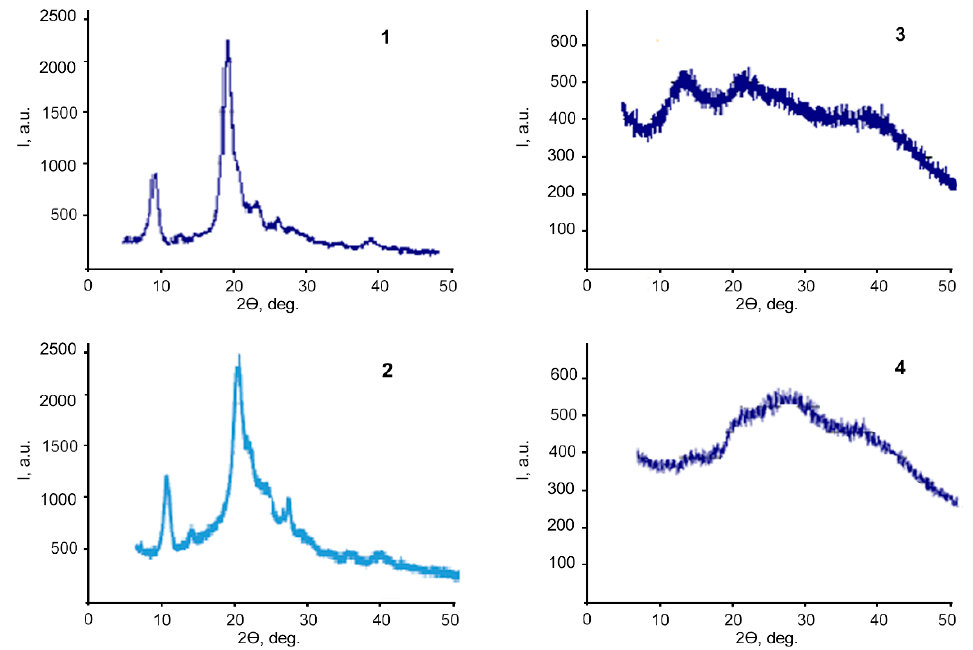
Figure 2. X-ray di ff raction patterns: 1—CNW; 2—lyophilized ALG-CNW microgel, isolated from the ALG-CNW (7.5%) hydrogel; 3—lyophilized ALG hydrogel; 4—lyophilized ALG-CNW